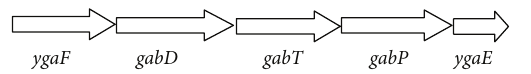
Figure 1: The gab operon structure in S . Typhi. The arrowhead representsthelengthofthegene;thearrowheadof ygaE corresponds to 0.678